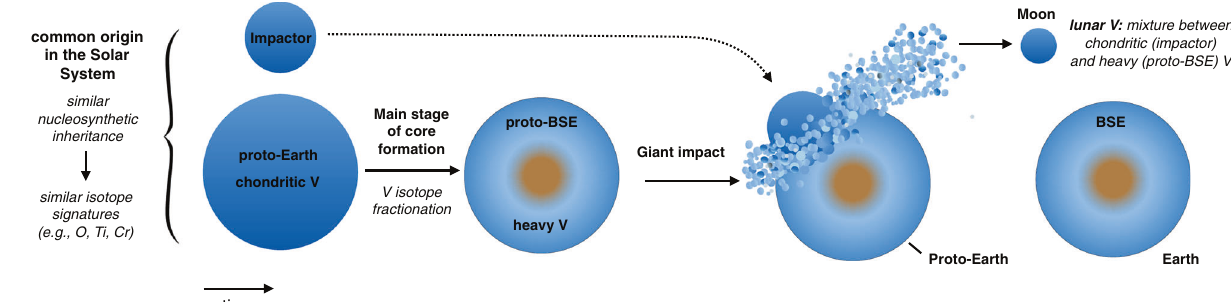
Fig. 4 Summary cartoon showing our preferred scenario for the origin of the V isotope composition of the Moon. Theia and proto-Earth would have mainly accreted from a common accretionary reservoir in the inner solar system (which is required to account for their similar nucleosynthetic inheritance) 5,6,9,39 . Subsequently, the proto-Earth experienced its main phase of core-formation at high pressure and high temperature, which caused the V isotope composition of the BSE to be enriched in 51 V relative to its originally chondritic composition 14 . A canonical giant impact between Theia (chondritic V isotope composition) and proto-Earth would then have produced the present-day Earth-Moon system, with ~80% of the lunar accretionary material deriving from the impactor and essentially no difference in the nucleosynthetic assemblages of the Earth